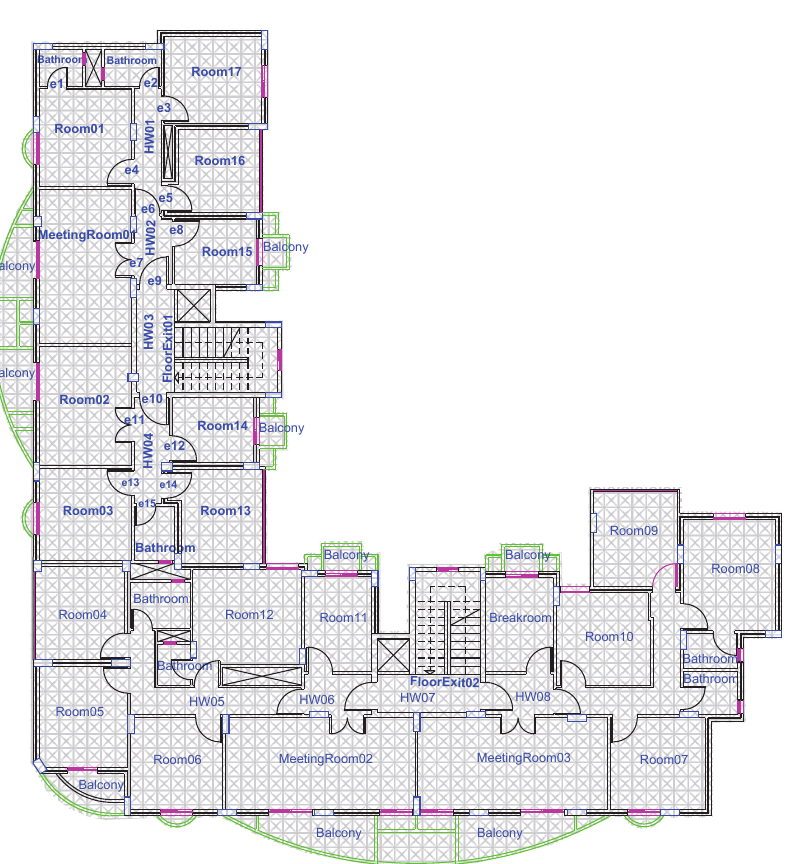
Figure 11: Example of a fi ne-grained graph of a fl oor